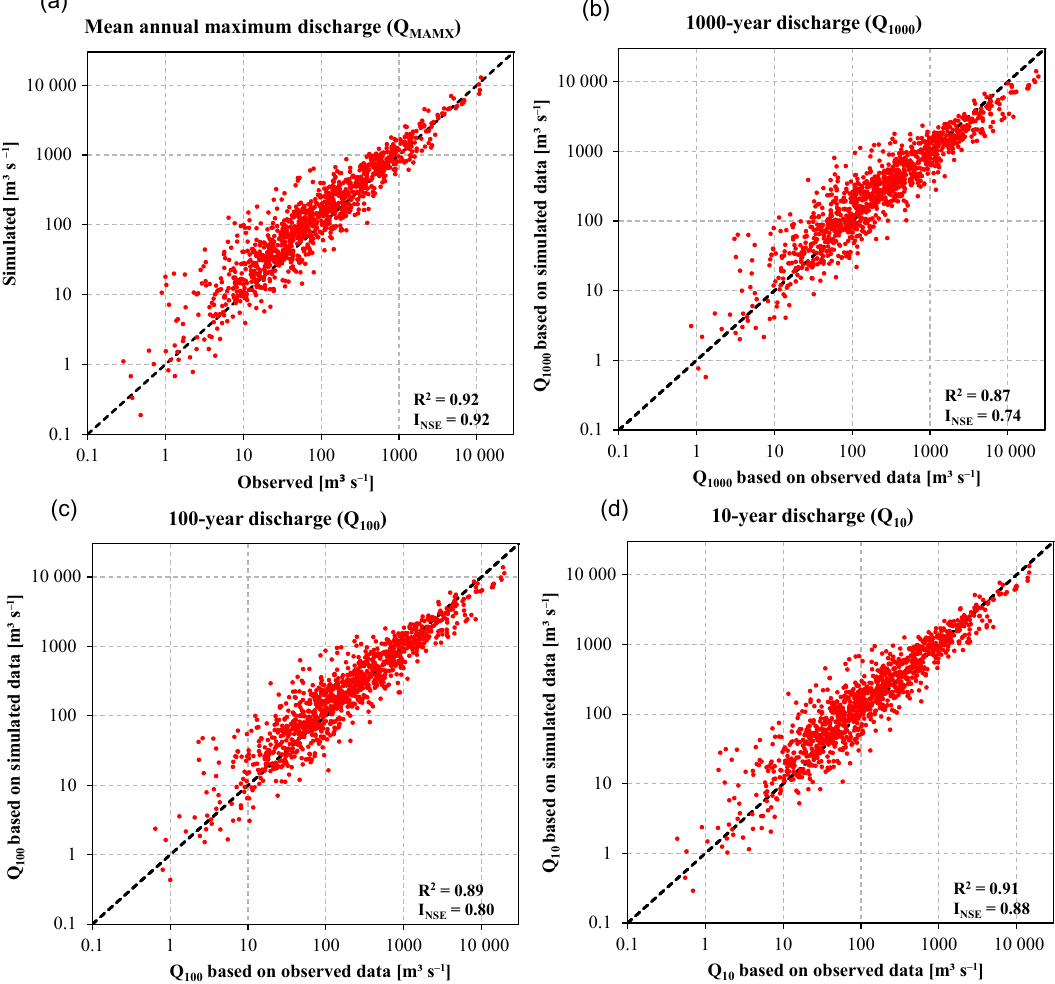
Figure 5. Simulated and observed average annual maxima of daily river discharges (a) and annual maxima fitted to Gumbel distribution to calculate 1000-, 100- and 10-year return periods (b–d) , for 1125 stations. 30-year periods of annual maxima were used (the most